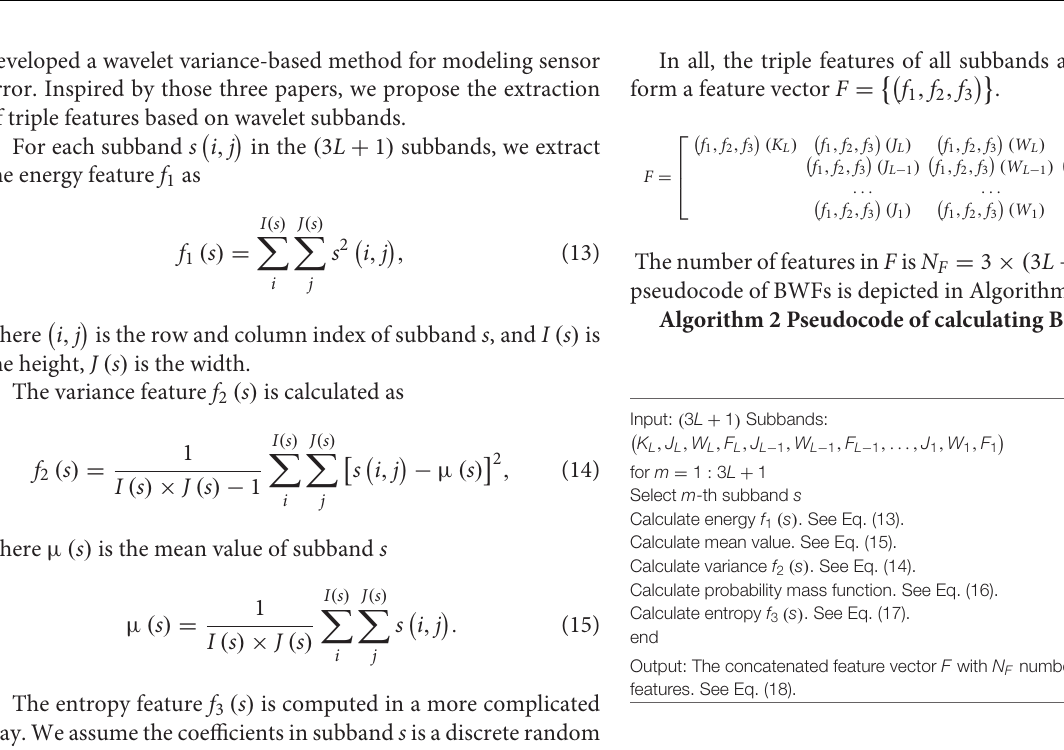
FIGURE 3 | Filters for bior4.4. (A) Decomposition low-pass filter. (B) Decomposition high-pass filter. (C) Reconstruction low-pass filter. (D) Reconstruction high-pass filter.